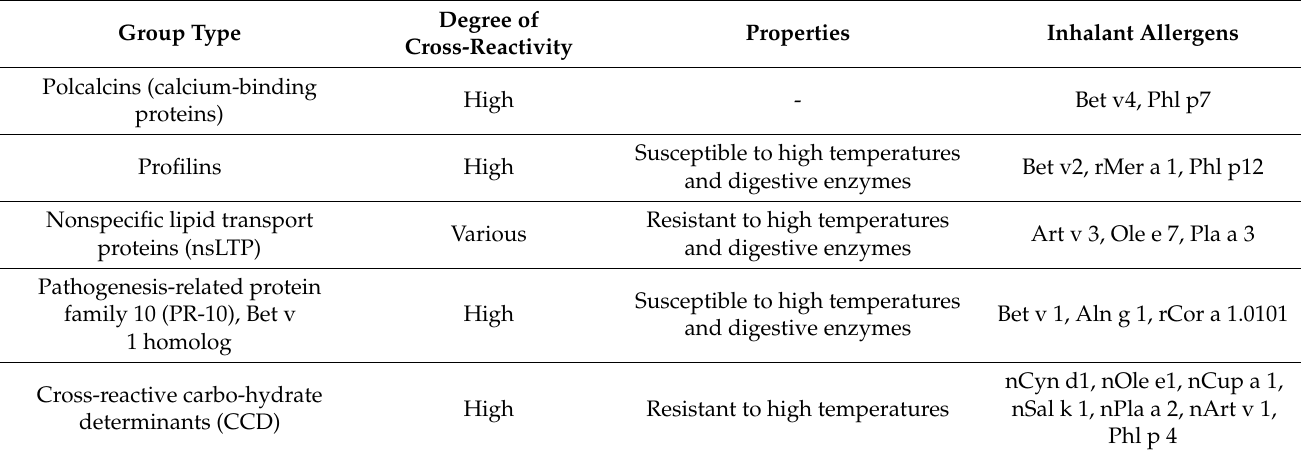
Table 3. Classification of protein families in seasonal allergic rhinitis